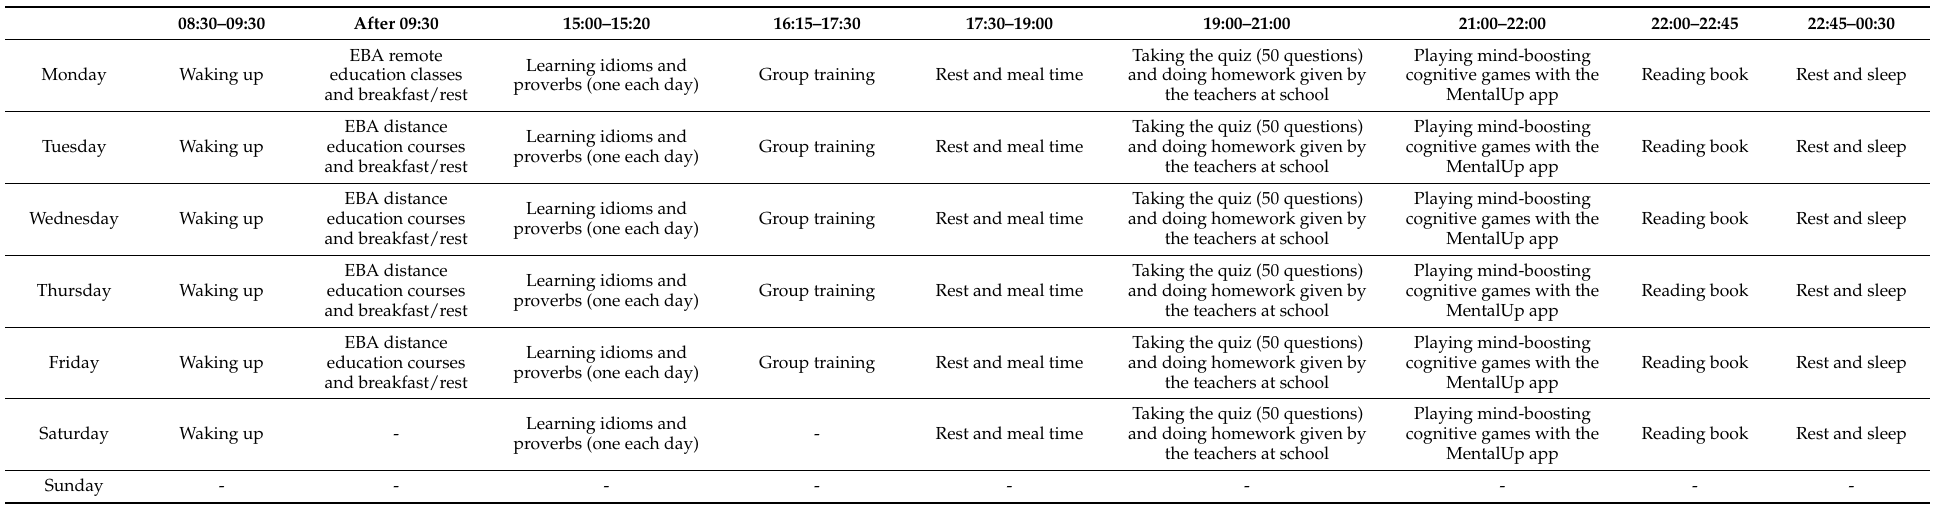
Table 3. The chart depicting one week of occupational balance